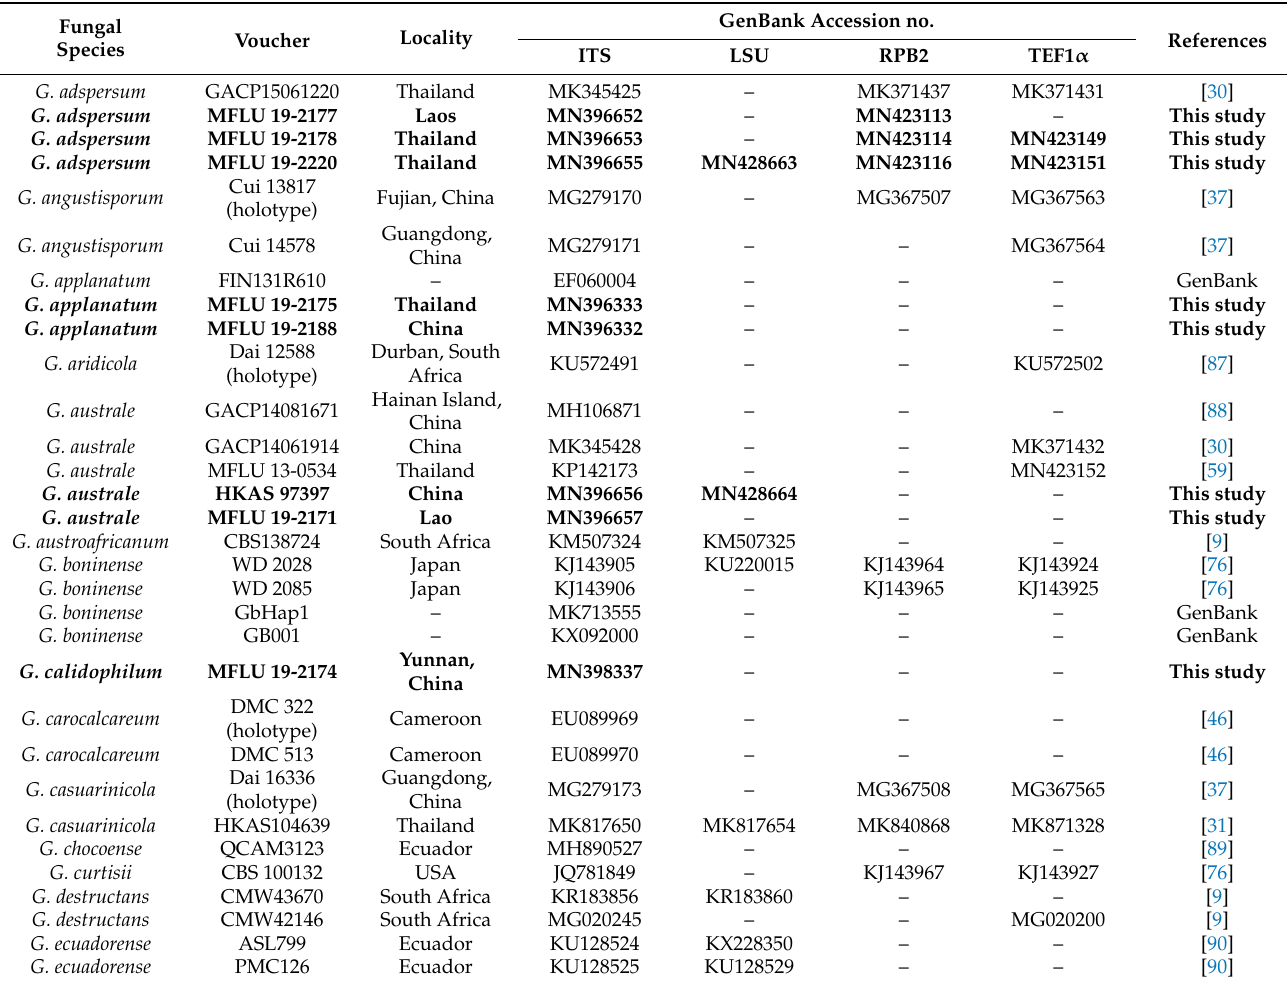
Table 3. GenBank accession numbers for ITS, LSU, TEF1 α , and RPB2 sequence data of the taxa used in this study and procured from GenBank based on the earlier studies for conducting phylogenetic analyses. Details of newly amplified sequences are represented in